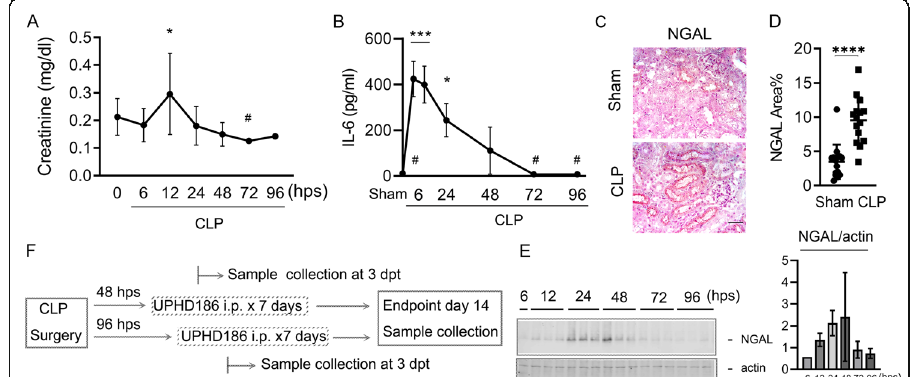
Fig. 2 Treatment window. Determination of treatment timing based on resolution of renal dysfunction and systemic inflammation. Time serial samples were obtained at 6~96 h after the initial insult. a – b Serial charts of creatinine and the circulating interleukin 6 (IL6) are shown (mean ± SD, N = 3~5) * P < 0.05, *** P < 0.001 compared to “ #. ” c – d Representative images of immune stain for NGAL in the kidneys collected at 48 h post-CLP (scale bar = 20 μ m) and the expression intensities for group each group of animals (mean ± SD, N = 15). e Blots of renal time serial NGAL and the corresponding intensities of the blots. f Schematic diagram of treatment timing and sample collection plan. Tukey ’ s test was used to determine the statistical significance among multiple groups and one-tailed Welch ’ s t test was used for two group comparisons. NGAL, neutrophil